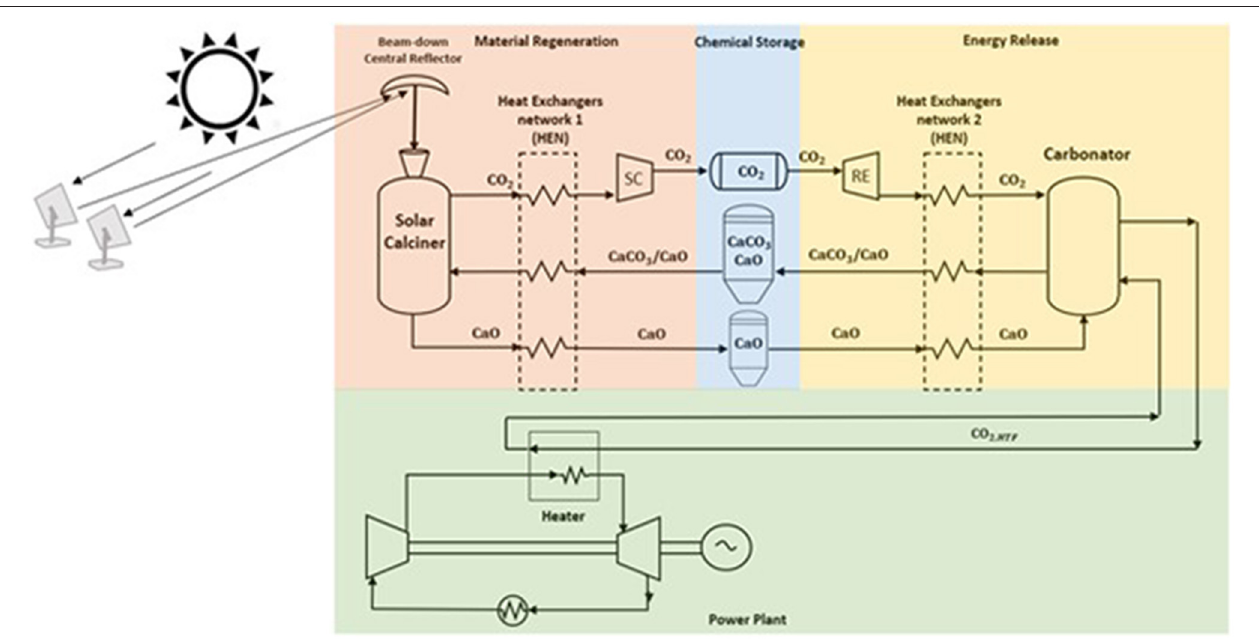
FIGURE 1 | Integrated solar calcium looping (IS-CaL) with direct calcination reaction in the solar calciner. The spent material flows into the solar calciner, a solid particle fluidized bed reactor with CO 2 , to store solar energy through sorbent regeneration. The compounds, produced at high temperatures, provide heat to the spent sorbent in the heat exchanger network, and then they are stored at ambient temperature to avoid thermal losses. Regenerated sorbents are preheated in HEN2, and the exothermic reaction occurs in the carbonator reactor providing heat at high temperature to a power